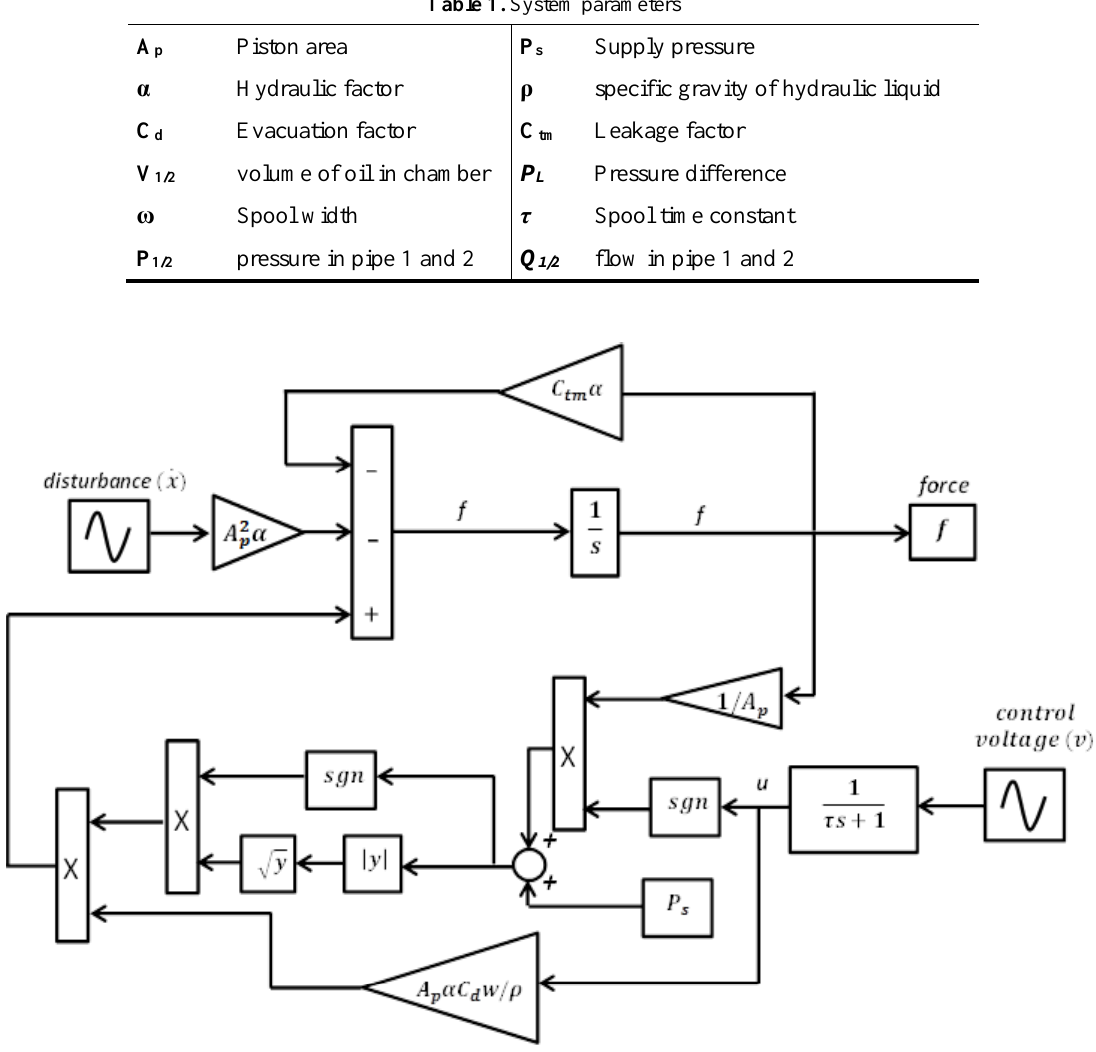
Figure 2. Matlab-Simulink block diagram of the nonlinear